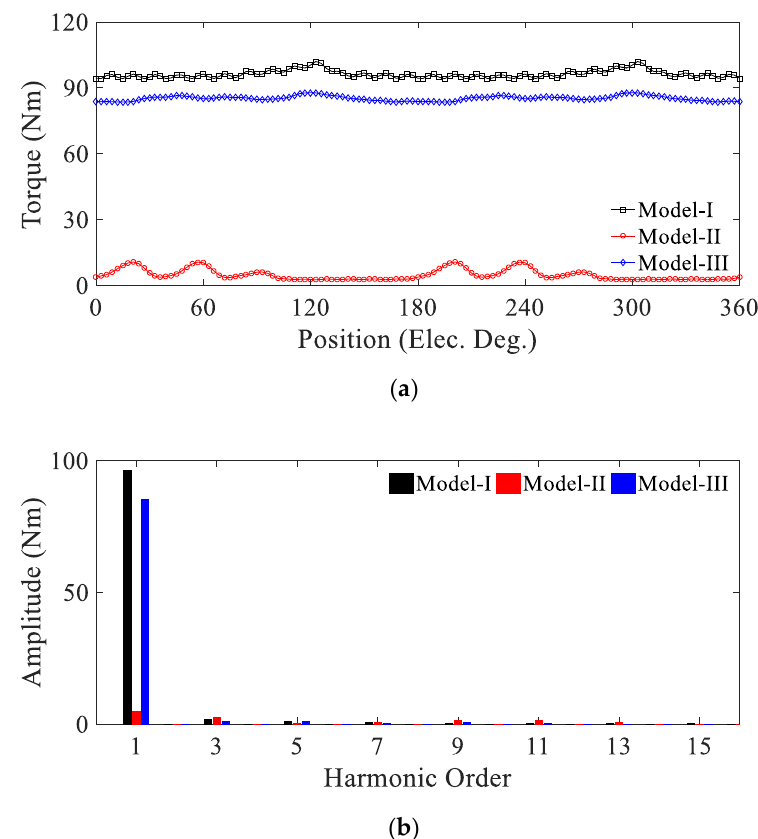
Figure 16. Optimized models:( a ) Average torque, ( b ) Torque FFT.